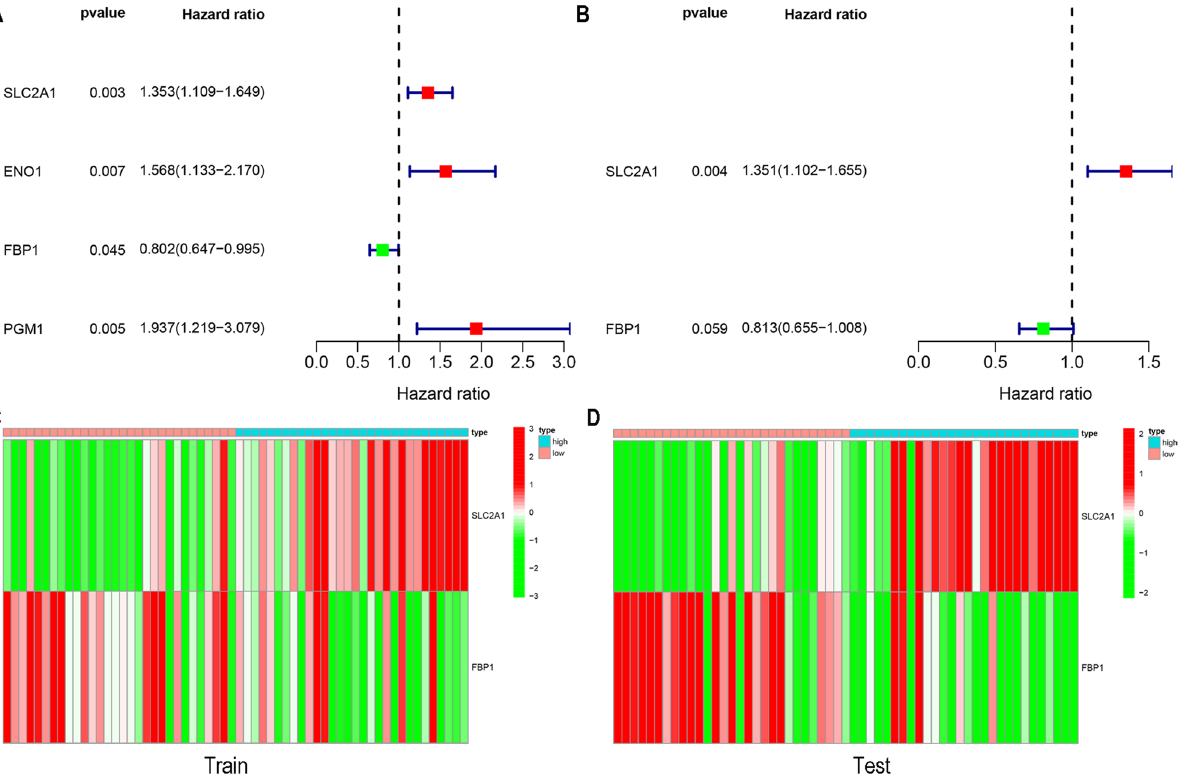
Figure 2. COX regression analysis ( A & B ) Single-factor COX regression analysis and multi-factor COX regression analysis select high-risk genes. ( C-D ) Draw two heat maps of the genes selected by the multivariate COX regression analysis to show the expression level of the genes in the train set and test